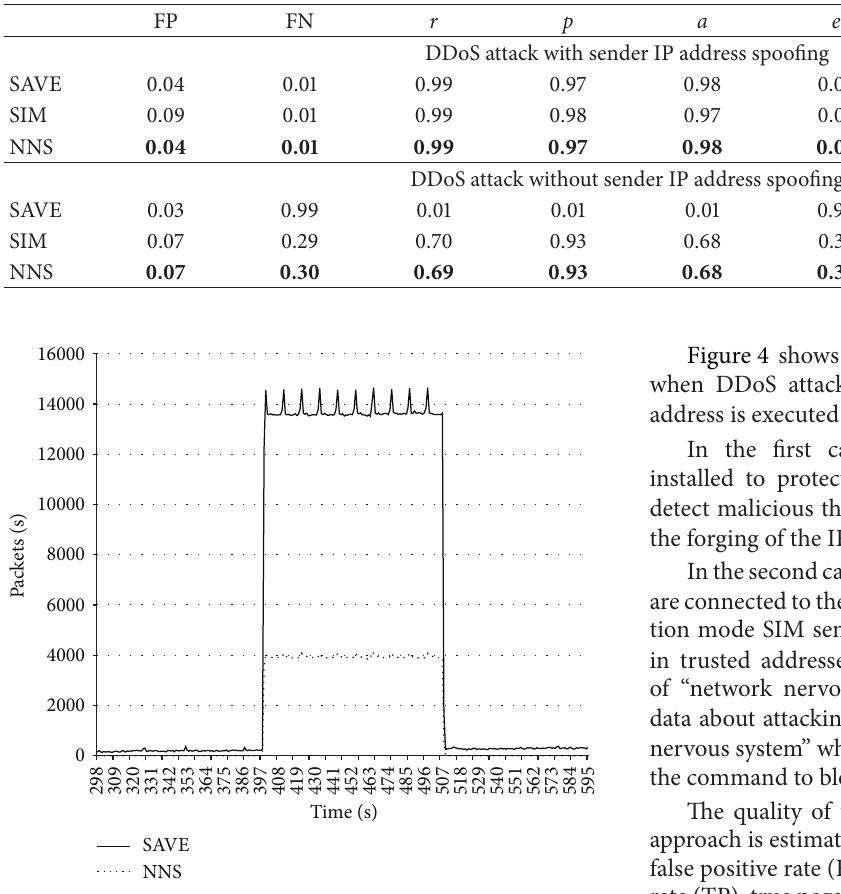
Figure 4: Volume of traffic on the attacked node in case of DDoS attack relative to simulation